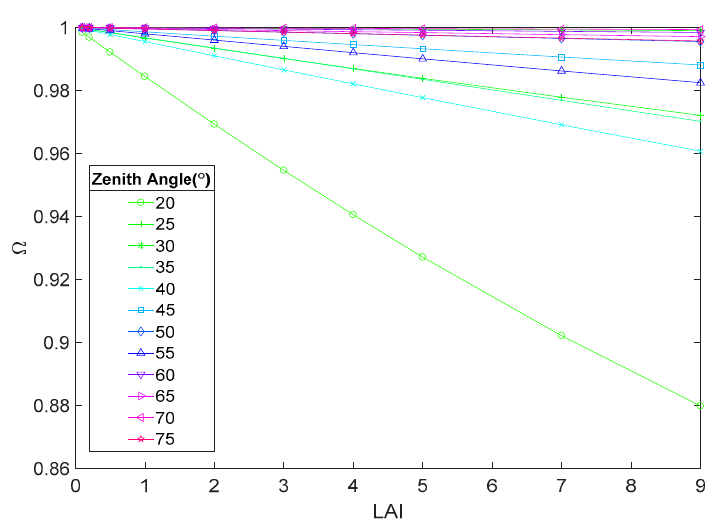
Figure 11. Effect of leaf area index (LAI) on crop clumping index. Different curves refer to different zenith angles (°). Simulation parameters: a 1 = 0.2, a 2 = 0.3, H = 1, r h g = 0.22, ρ 1 = 0.0999, T 1 = 0.1303.